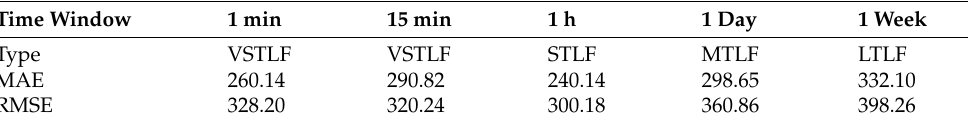
Table 4. The experimental results for different time